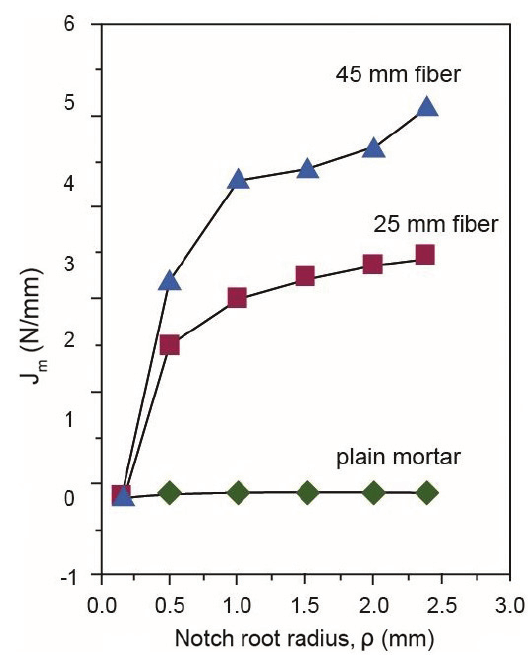
Figure 9. Variation of J and reinforced